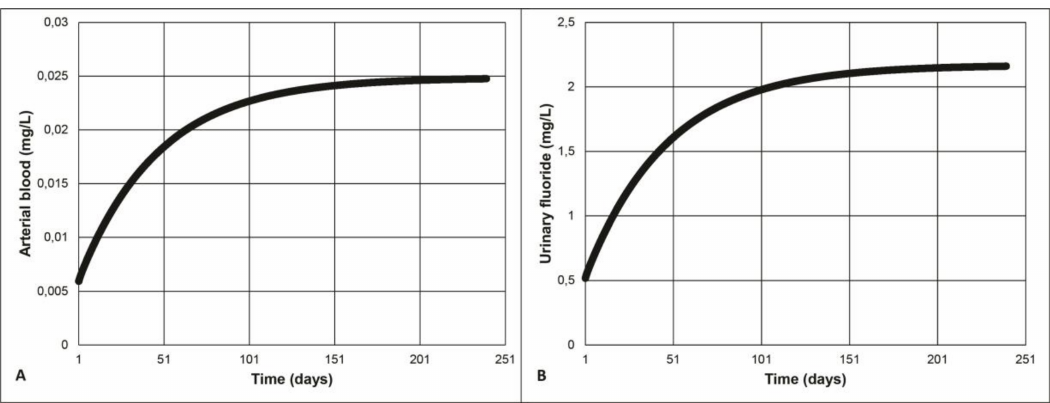
Figure 2. ( A ) Arterial and ( B ) urinary fluoride concentration in a 4-year-old child continuously exposed to 0.7 mg/L of fluoridated water.